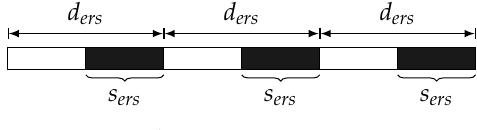
Figure 8. ERS characteristics.